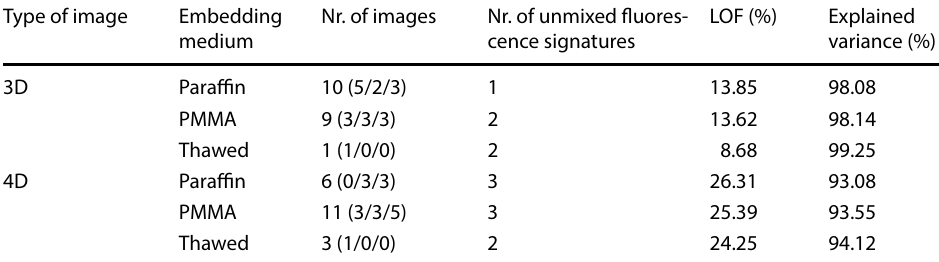
Table 1 Summary of image multisets analyzed, MCR- ALS model parameters, and primary results (number of unmixed fluorescence signatures